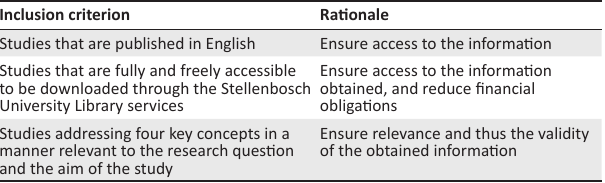
TABLE 2: Inclusion criteria.